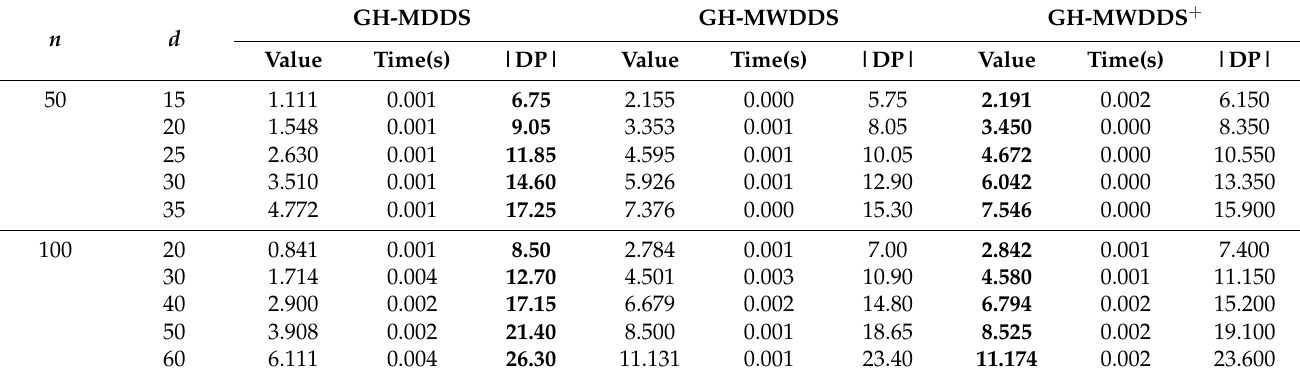
Table 2. Numerical results of comparison between GH-MDDS, GH-MWDDS and GH-MWDDS